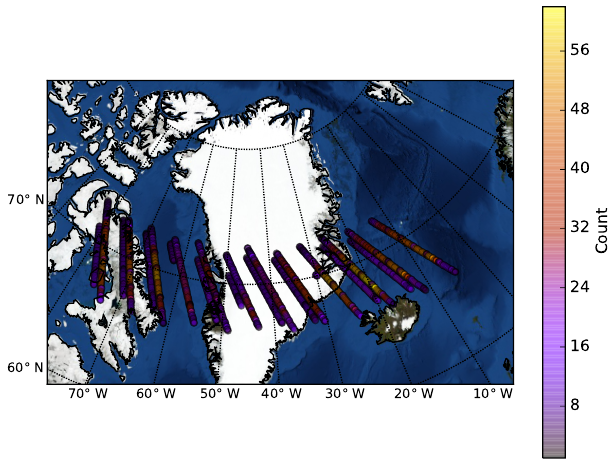
Figure 1. CALIOP sampling over the study region of